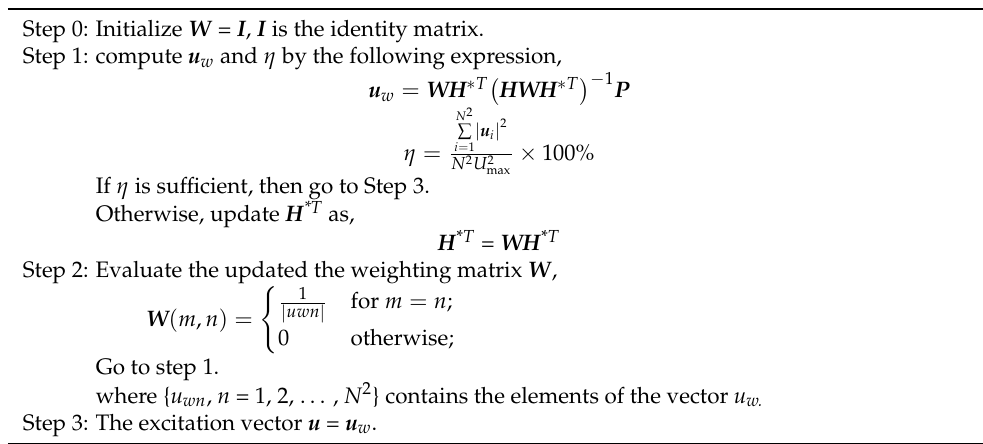
Table 1. Weighted iterative optimization algorithm.